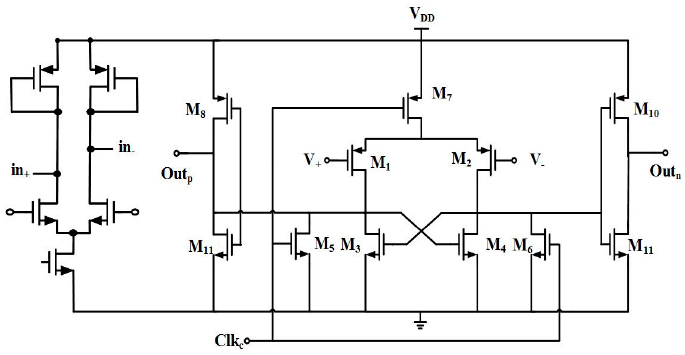
Figure 9. Comparator circuit implemented in the 12-bit hybrid SAR ADC.